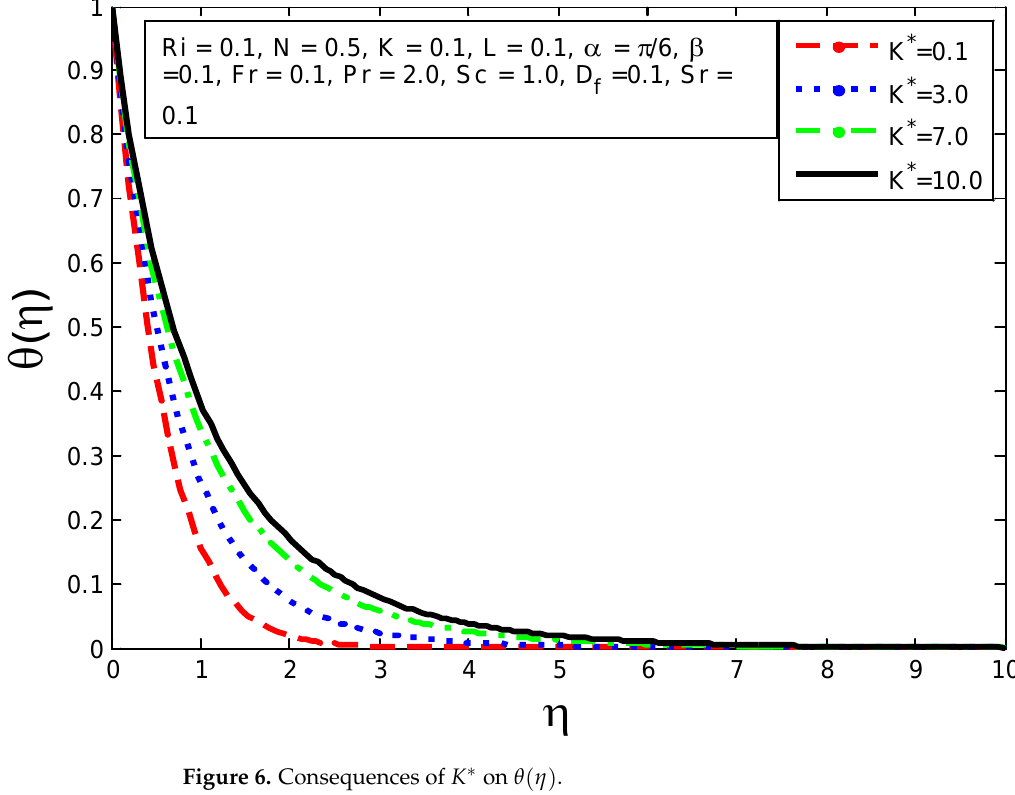
Figure 6. Consequences of K ∗ on θ ( η ) .